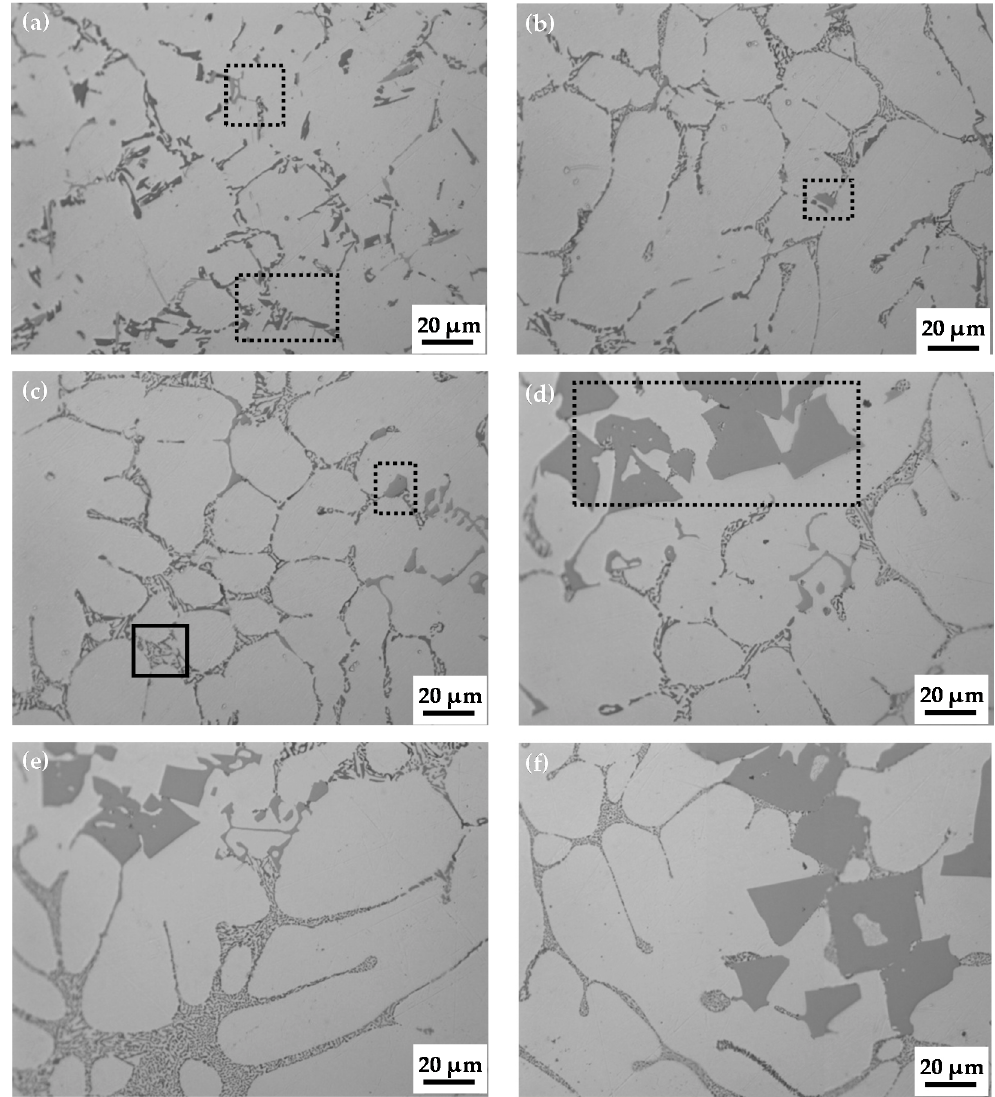
Figure 2. Microstructures of Al-5Si-0.8Mg alloy ingots ( a ) without Mn and those with ( b ) 0.45% Mn, ( c ) 0.72% Mn, ( d ) 1.09% Mn, ( e ) 1.65% Mn, and ( f ) 1.97% Mn.